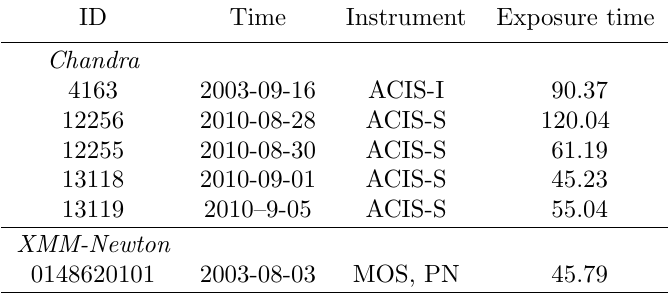
Table 1. The list of X-ray observations of